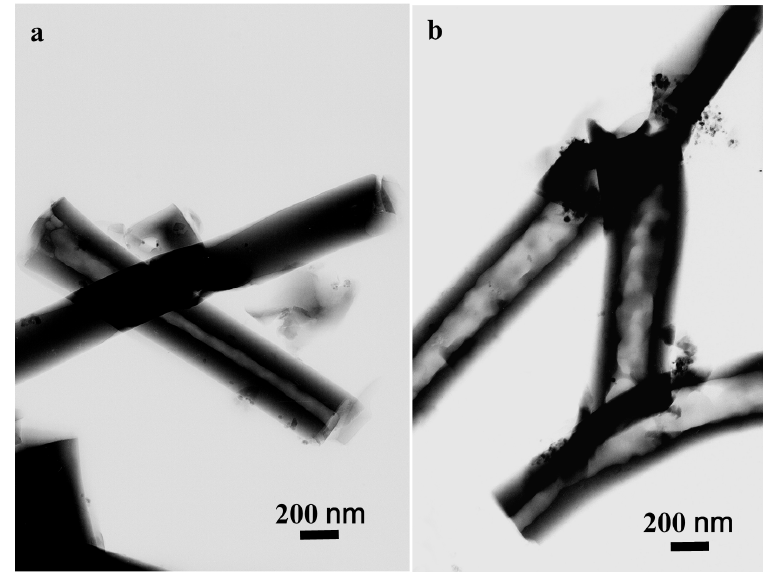
Figure 4. Transmission electron microscopy (TEM) images of ( a ) as-prepared SiO 2 sub-micron fibers with both hollow and solid structures; ( b ) SiO 2 /ZnO composite hollow sub-micron fibers. On the basis of the above results, the possible gases generated and the directional escaped growth mechanism were proposed. During the calcination process, PVP became viscous and the fibers were plasticized with the increase of temperature, carbon monoxide and other gases were evaporated rapidly. All the gases escaped to the outside of the fibers through two pathways: along